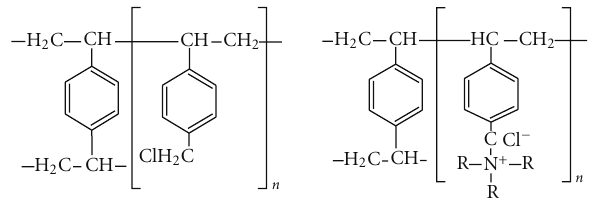
Figure 1: The structure of the base membrane and anion exchange